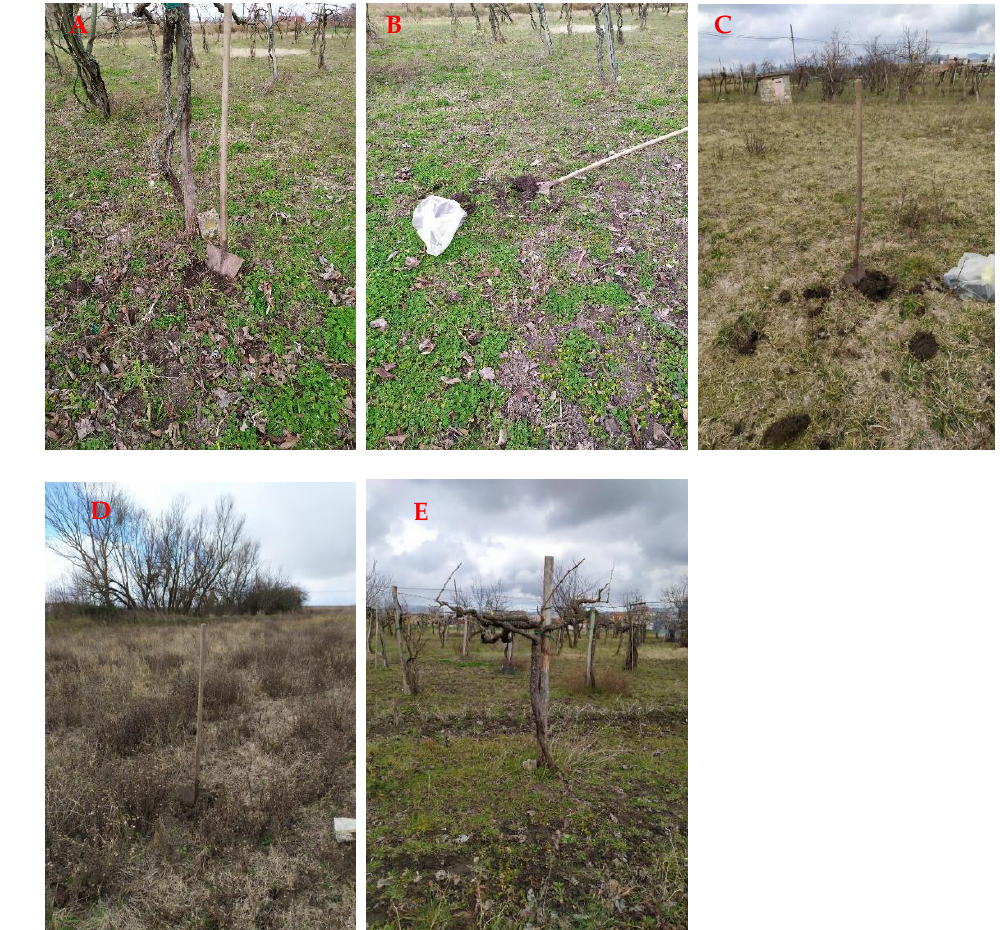
Figure 2. Sampling at the foot of the grapevines in V50 ( A ); in the middle of the grapevines in V50 ( B ); in a grapevine-free control area (Tr), ( C ); in ST20 ( D ). A 50-year-old grapevine specimen ( E